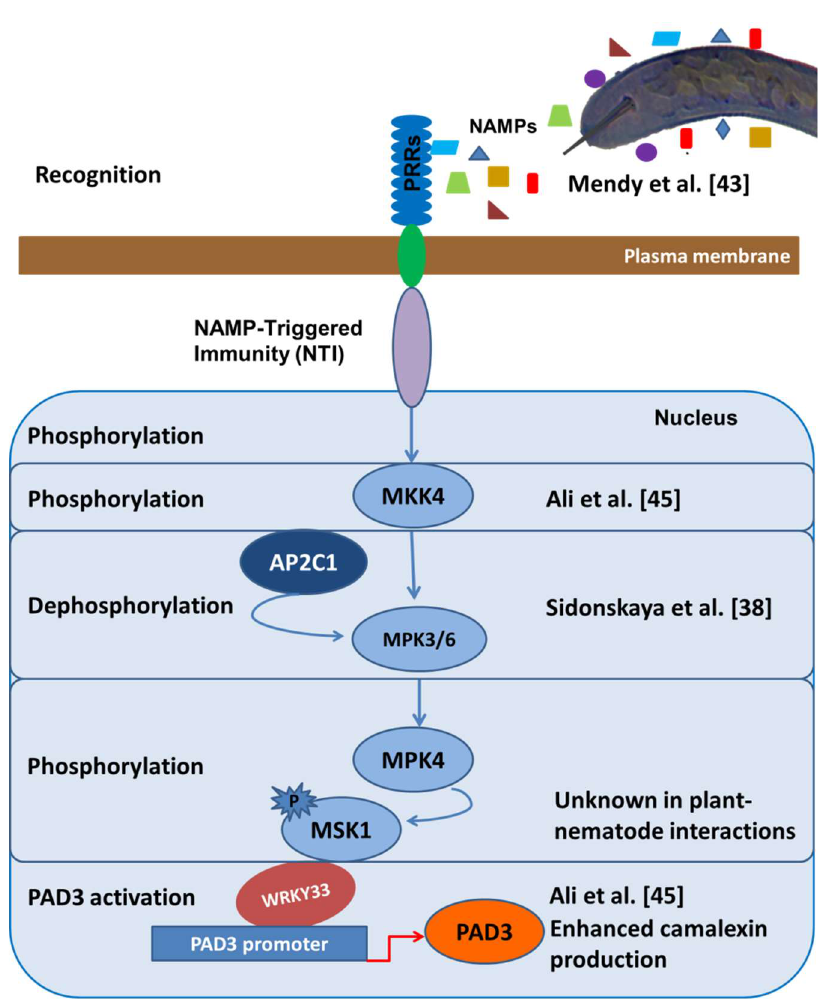
Figure 1. Hypothetical overview of nematode-associated molecular pattern (NAMP)-triggered immunity (NTI) in the Arabidopsis -beet cyst nematode H. schachtii model system. NAMPs are specific molecular patterns released by plant parasitic nematodes which are recognized by transmembrane receptors such as kinases on the host to induce a signaling cascade [13]. The overexpression of MKK4 in Arabidopsis led to increased resistance against beet cyst nematode as compared to wild type, suggesting an important role of MKK4 in signal transduction in plant immunity [45]. MAPK phosphatase AP2C1 may be involved in the putative dephosphorylation of MKK (MAP kinase kinase) into the MPK3 and MPK6 kinases to further transduce the signal for nematode resistance [38]. We have experimentally demonstrated that the overexpression of WRKY33 and the knocking-out of PAD3 resulted in enhanced nematode resistance, which highly support our hypothesis that the phosphorylation cascade involving WRKY33 leads to camalexin biosynthesis which in turn leads to NTI [45]. Although some steps, such as the phosphorylation of MKK4 and MSK1 and the activation of WRKY33 , in this cascade have not yet been demonstrated in plant–nematode interactions, the proposed NTI model indicates the importance of WRKY33 -dependent camalexin production in Arabidopsis .